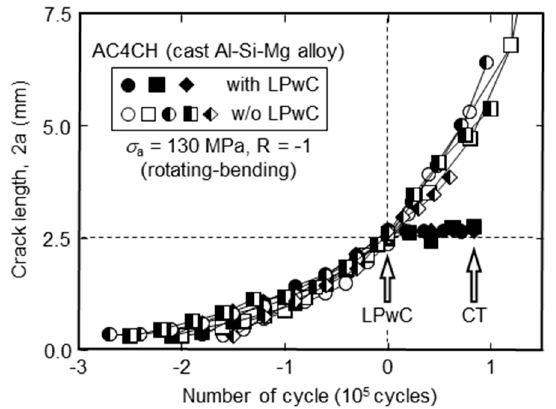
Figure 2. Crack growth behavior of AC4CH fatigue samples. Each curve is shifted so that the fatigue cycle at the crack length of 2.5 mm is the origin of the horizontal axis. Laser peening without coating (LPwC) was applied, and fatigue loading continued. Computed tomography (CT) was performed after an additional 10 5 loading cycles at SPring-8.